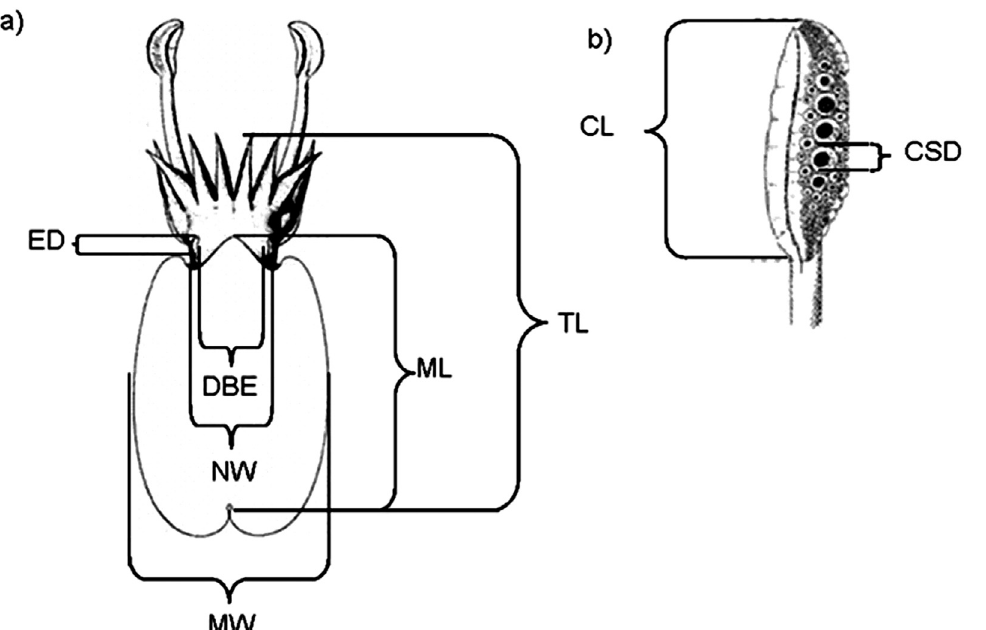
Fig. 2. – morphometric characters of S. officinalis measured: a) dorsal view, b) tentacular club, Tl total lenght; ml mantle length; mW mantle width: nW neck width; eD eye diameter; CSD club sucker diameter; Cl club length; DBe distance between